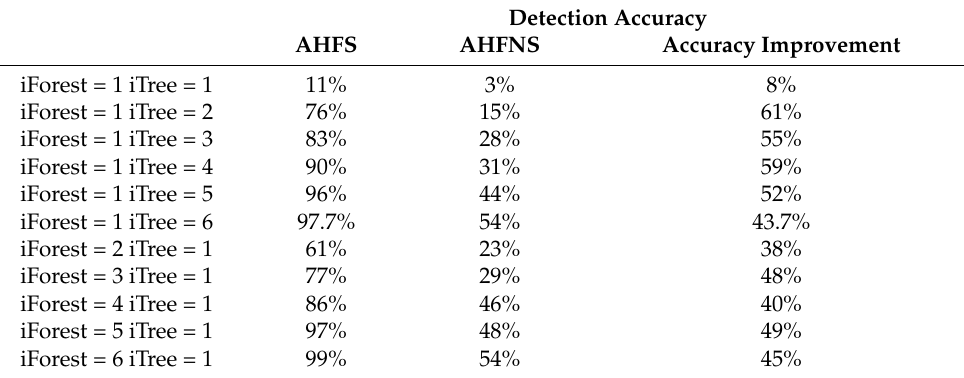
Table 4. The detection accuracy of the proposal with different N f , N t